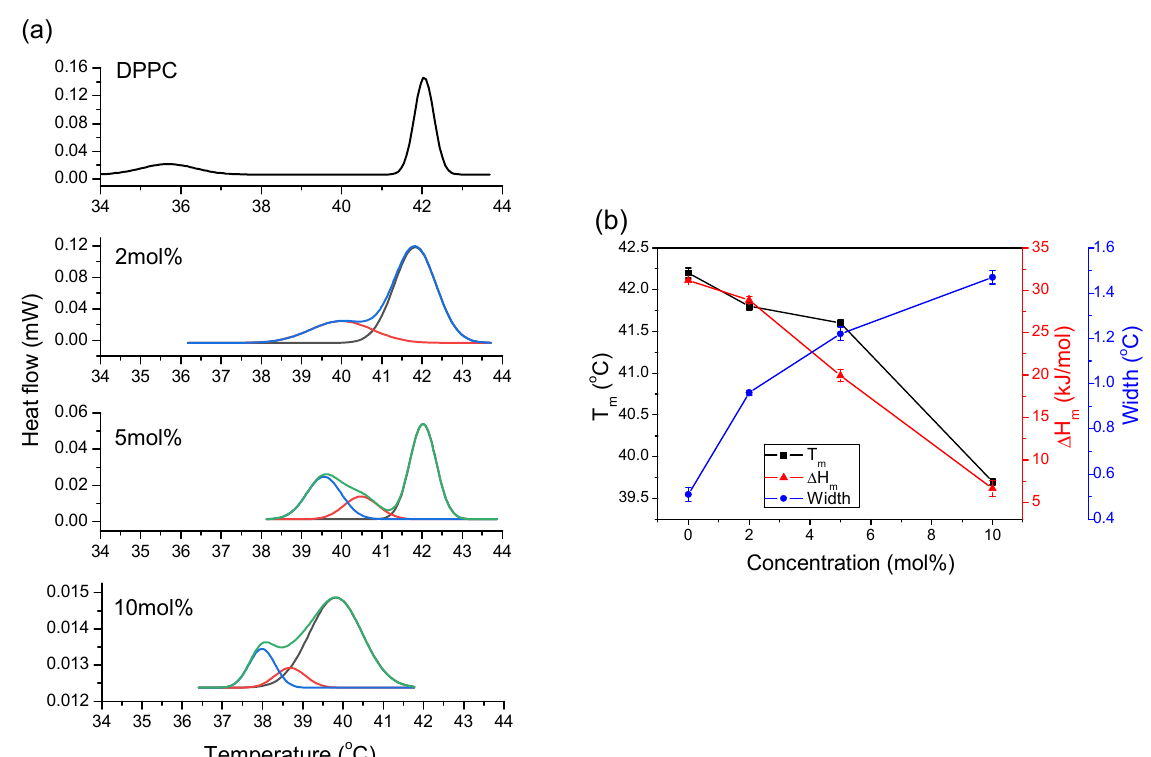
Figure 4. ( a ) Smoothed DSC traces of DPPC liposomes (2 mg/mL), with an increasing concentration of CT, given in the plot. The plot also shows the fitted components to the total DSC trace. Please note the decreasing intensity on the ordinate axis; ( b ) effect of incorporation of different concentrations of CT into DPPC on the main phase transition temperature, T m , the width of the main peak, and the enthalpy of transition, ∆ H m . Please note decreasing values on y -axis plots.